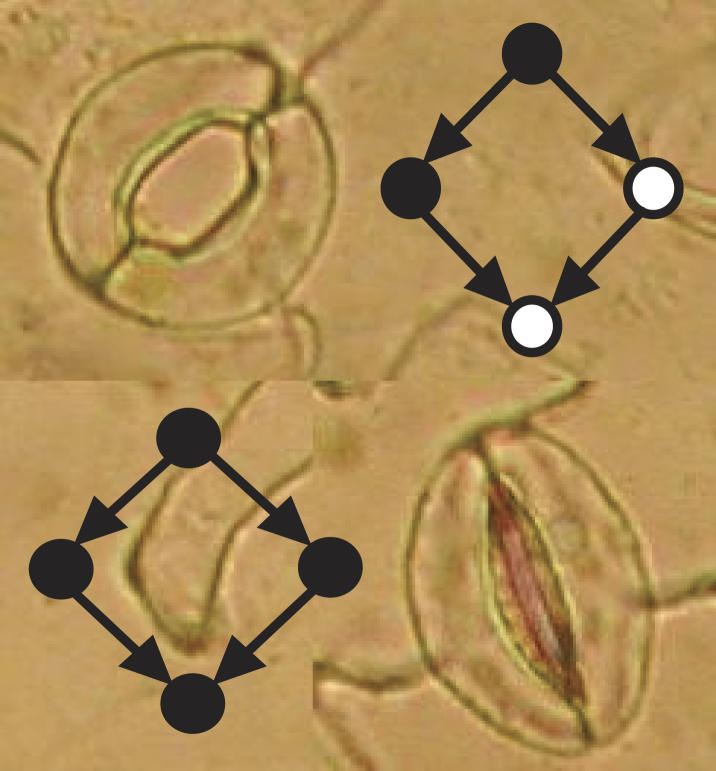
The authors model guard cell opening (upper panel) and closing (lower panel) in response to the plant hormone abscisic acid. (Image: Song Li)